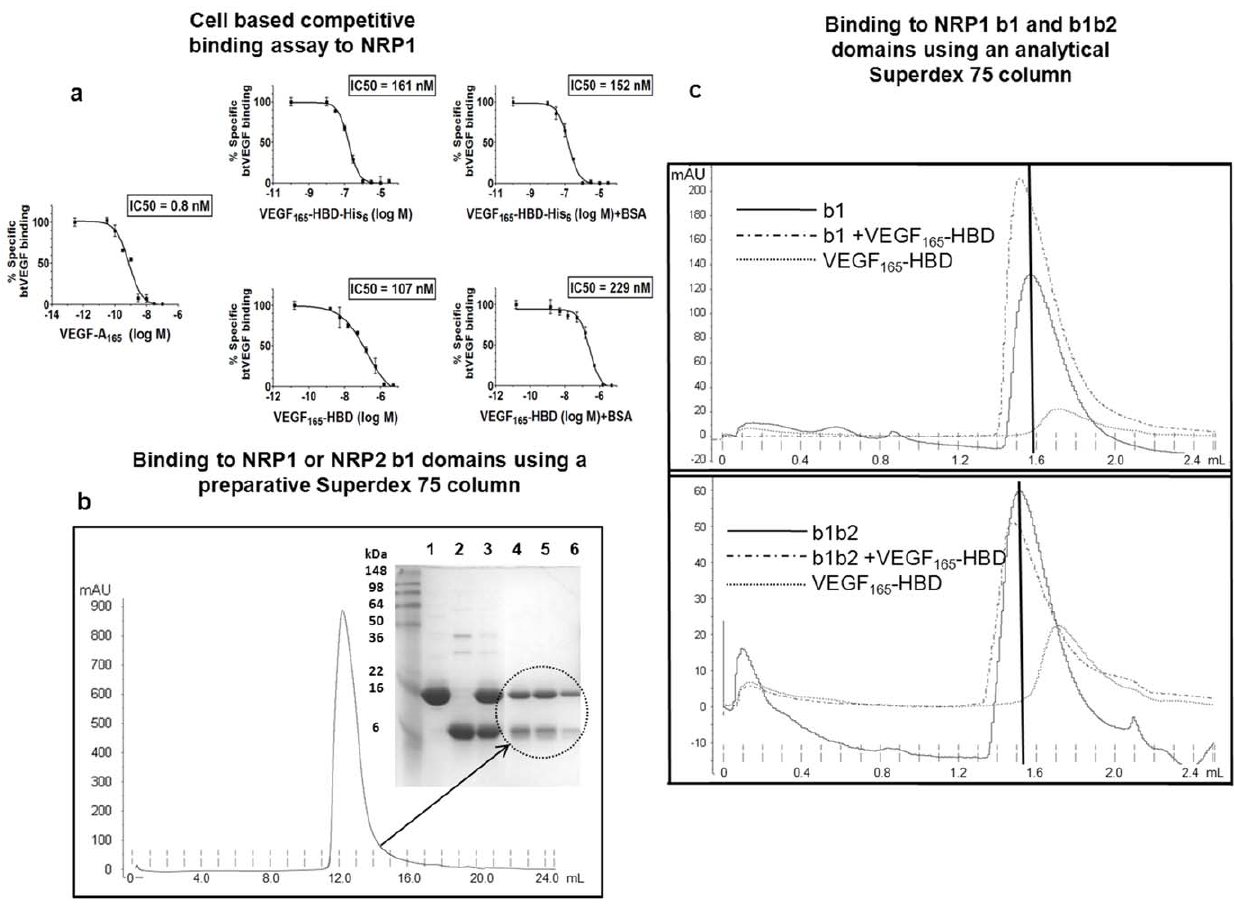
Figure 2. Binding of VEGF-A 165 -HBD to NRP as detected by a cell based assay and size exclusion chromatography. (a) Binding of VEGF-A 165 -HBD to NRP1 was determined in DU145 cells expressing an adenoviral construct encoding NRP1 [17]. These cells do not express other VEGF receptors [21]. Cells were incubated with biotinylated VEGF-A 165 in the presence of the indicated concentrations of either unlabelled VEGF-A 165 (positive control), or VEGF-A 165 -HBD containing a His 6 tag or VEGF-A 165 -HBD without the tag. Values presented are the means ( 6 SEM) obtained from two independent experiments. Other experimental details are described in Materials and Methods. (b) Binding of VEGF-A 165 -HBD to b1 domains of NRP1 and NRP2 was assessed by size exclusion chromatography. The protein mixtures of a tenfold molar excess of VEGF-A 165 -HBD with the purified b1 domain from either NRP1 or NRP2 were incubated at room temperature for 30 minutes. The FPLC profile for VEGF-A 165 -HBD and NRP1 b1 mixture is shown. SDS-PAGE analysis was used to evaluate samples of NRP1 b1, VEGF-A 165 -HBD, and the protein mixture before being loaded onto the size exclusion column (lanes 1–3, respectively) as well as samples of fractions which eluted from the single peak (lanes 4–6), showing that VEGF-A 165 -HBD and NRP1 b1 co-eluted from the preparative Superdex 75 column. A similar result was seen for VEGF-A 165 -HBD and NRP2 b1. (c) Formation of the molecular complexes was also investigated by analytical size exclusion chromatography. NRP1 b1 and b1b2 domains as well VEGF-A 165 -HBD were initially loaded separately onto the analytical Superdex 75 column and their corresponding FPLC traces are shown in solid and dashed lines, respectively. To detect binding, NRP1 b1 or b1b2 domains were mixed with VEGF-A 165 -HBD in solution at a molar ratio of 1:10 and 1:28, respectively and incubated for an hour at room temperature. The mixtures were then applied to the column. The main peaks in the elution profiles revealed a shift to the left of the peak positions corresponding to the unbound NRP1 b1 or b1b2 domains (indicated by vertical black lines), suggesting complex formation. analysis of VEGF-A 165 -HBD/NRP interaction was carried out by column (GE Healthcare, # 17-0771-01). This observation is also using analytical size exclusion chromatography. VEGF-A 165 - not dependent on presence of the N-terminal affinity tag. Binding HBD, NRP b1 and b1b2 domains were purified and dialysed in of NRP1 and NRP2 b1 domains to VEGF-A 165 -HBD was assessed buffer consisting of 50 mM Tris pH 7.9 and 100 mM NaCl. To test the binding of VEGF-A 165 -HBD to NRP b1 domain, a molar by mixing a tenfold excess of VEGF-A 165 -HBD with NRP1 and NRP2 b1 domains (at concentrations of 0.6 mM VEGF-A 165 - ratio of 1:10 (NRP: VEGF-A 165 -HBD) was used and the mixture HBD and 0.06 mM NRP b1). All proteins were purified and incubated at room temperature for an hour. Based on the elution dialysed in buffer consisting of 50 mM Tris pH 7.9 and 100 mM profiles from the analytical Superdex 75 column it was apparent NaCl prior to mixing. The protein mixtures were incubated at that the eluting peak for the mixture had shifted to the left (in room temperature for 30 minutes and then loaded onto a pre- comparison to the NRP b1 peak) indicating that the complex had parative Superdex 75 column. The eluted fractions from a single formed. A similar approach was taken to test the binding of peak were analysed by SDS-PAGE which revealed the presence of VEGF-A 165 -HBD and NRP b1b2 domain except that the molar both VEGF-A 165 -HBD and NRP1 or NRP2 b1 domains. Further ratio used was 1:28.